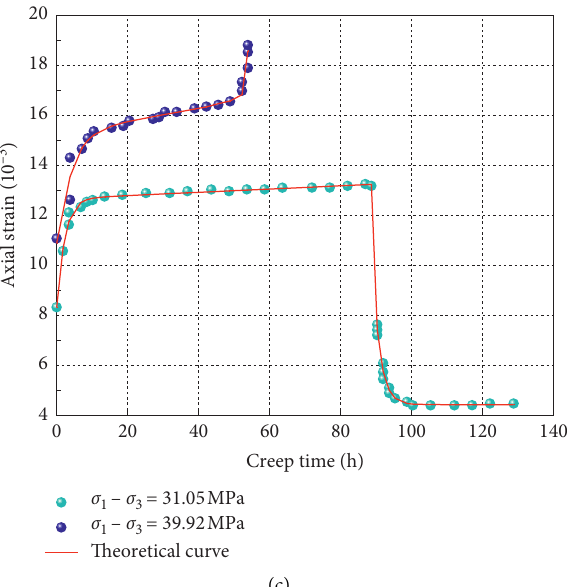
Figure 5: Comparisons between the nonlinear damage creep model and experimental curves at various deviatoric stresses for lherzolite specimen: (a) first stress (13.3 MPa) and second stress (22.1MPa); (b) third stress (26.6 MPa) and fourth stress (28.8 MPa); (c) fifth stress (31.0 MPa) and sixth stress (39.9 MPa).